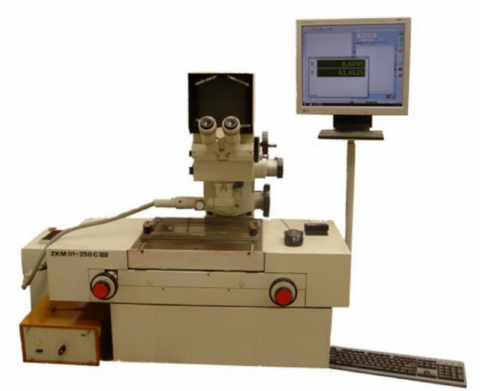
Figure 2. Zeiss measuring microscope—ZKM 01-250